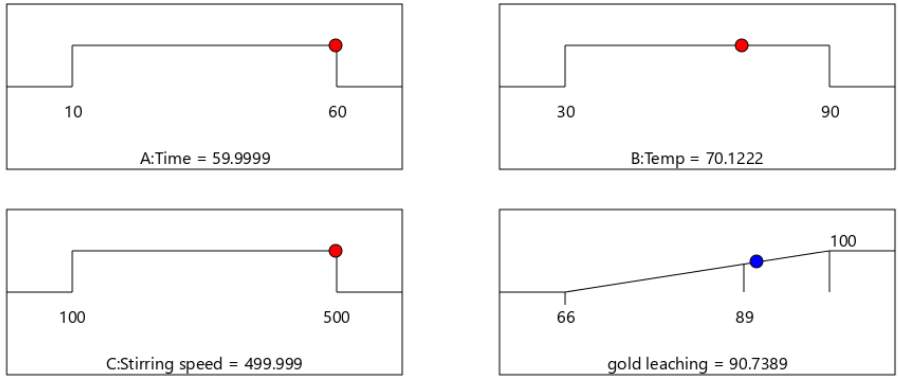
Figure 7. Optimization of parameters for the leaching of gold.